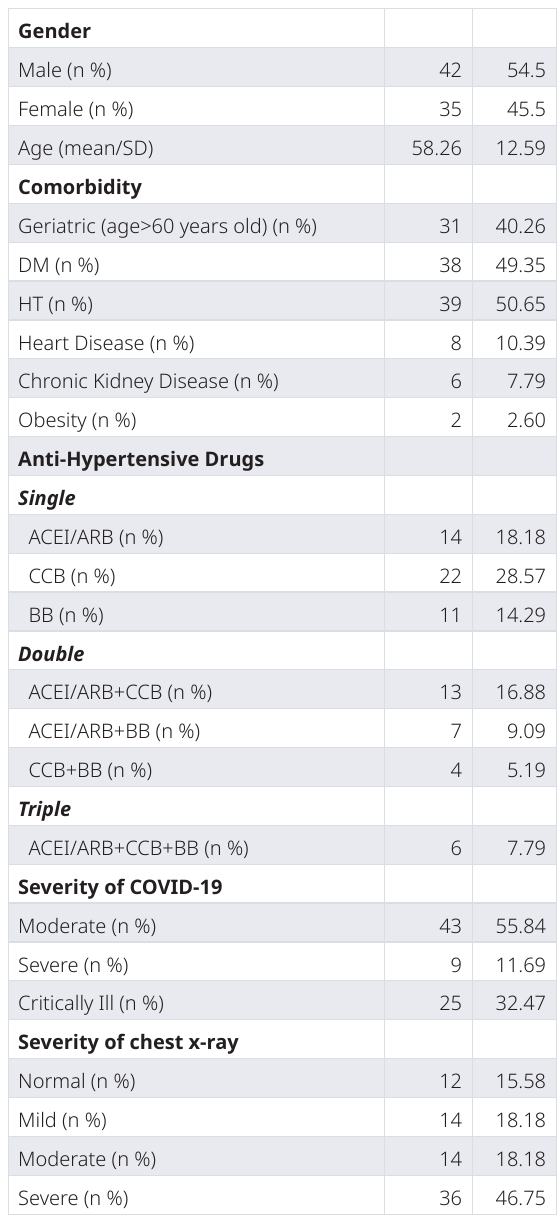
Table 1. Characteristics of patients. ACEI/ARB: angiotensin-converting enzyme inhibitors and